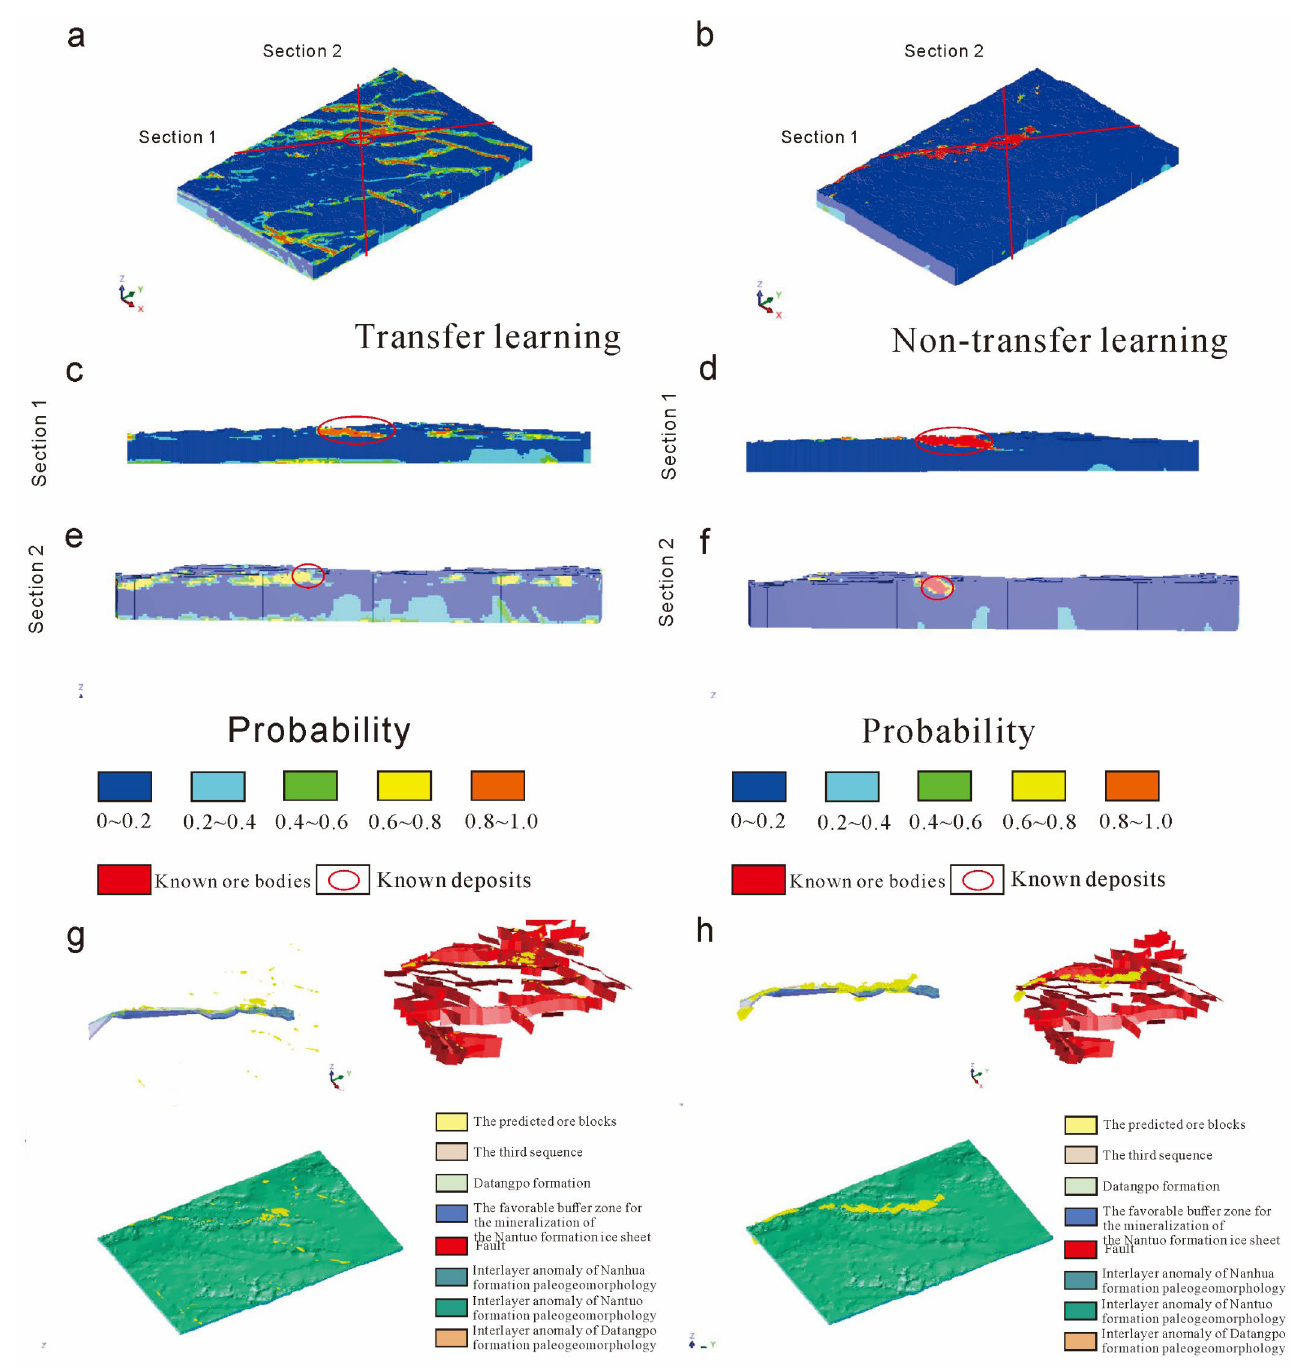
Figure 16. The results comparison of 3D metallogenic prospect delineation in test 5. ( a , c , e ) show the prediction results of the 3DCNN-TL model; ( b , d , f ) show the prediction results of the 3D CNN. ( g ) shows the target section delineated by the 3D CNN-TL prediction model when the threshold value of the metallogenic prospect is 0.65, and ( h ) shows the target section delineated by the 3D CNN model.